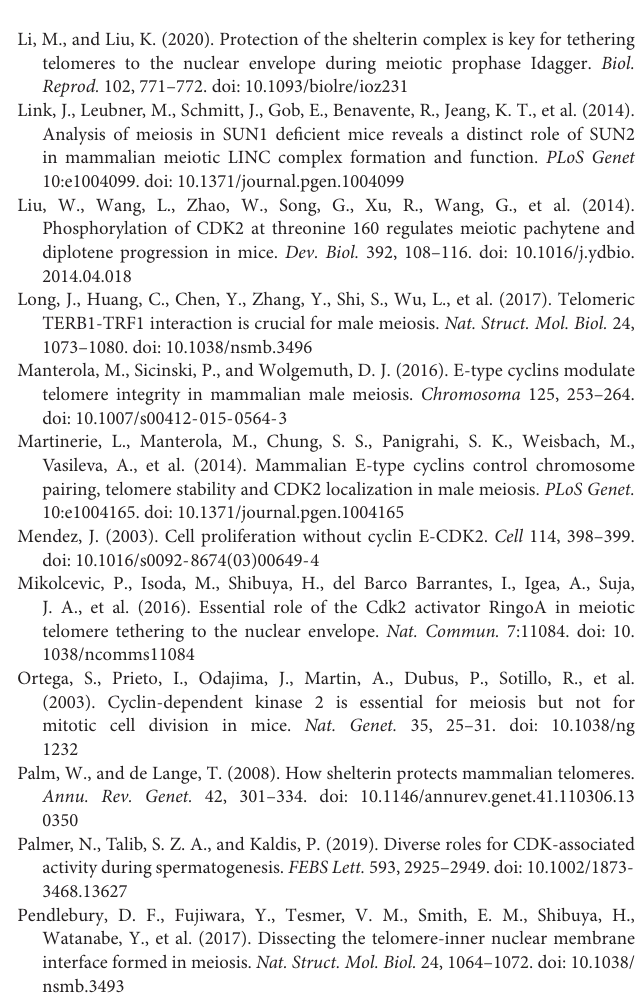
FIGURE S1 | Nuclear envelope localization of TERB1 and TERB2 is dependent on MAJIN but not SUN1. (A,B,E) Expression plasmids were transfected into Cos7 cells, and then immunofluorescence assays were carried out. Nuclei were stained with Hoechst 33342. mCh: mCherry. Scale bar = 20 µ m. (A) Cellular localization of TERB1, TERB2, and MAJIN. (B) Nuclear envelope localization of TERB1 and TERB2 is dependent on MAJIN. (E) Nuclear envelope localization of TERB1 and TERB2 is independent of SUN1. (C,D) Expression plasmids were transfected into HEK293T cells, and immunoprecipitation was performed to analyze the interactions of TERB1-TERB2-MAJIN. FIGURE S2 | Sequence alignment of human and mouse SUN1. FIGURE S3 | Uncropped images presented in Figure 4B . ∗ Indicating the band of GFP-SUN1 1–210 Aa (cid:49) 134 − 171